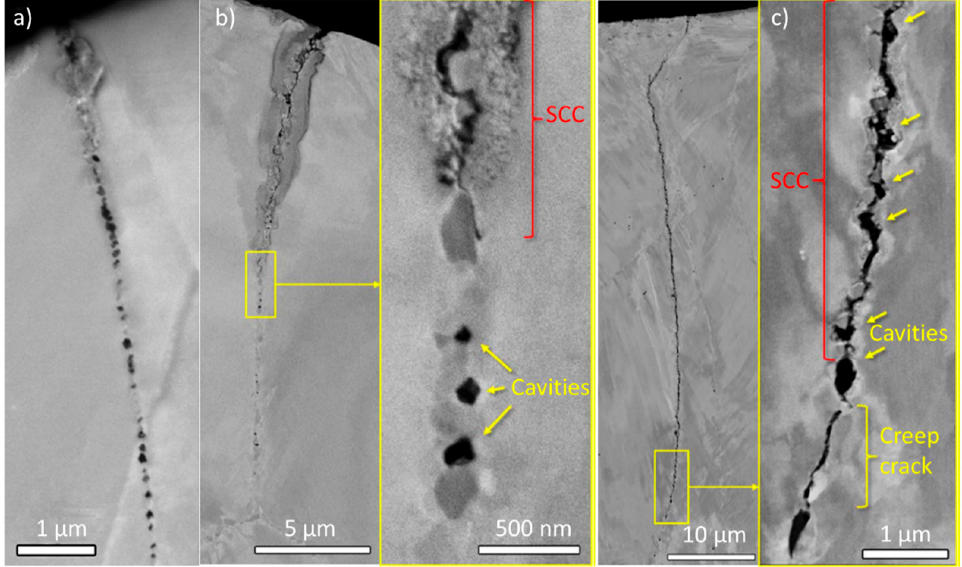
Figure 8. SEM-BSE images of cross-sections of EAC initiation in 21–31% CW Alloy 690, after testing conducted at 360 °C in simulated PWR primary water (600 ppm of B; 1 ppm of Li; 25 cc/kg dissolved H, i.e., in Ni/NiO transition conditions), showing the presence of GB cavities assisting the cracking. Three examples of the GB cavities are shown: ( a ) the first penetration at 5,352 h, ( b ) a shallow IG crack at 10,049 h, and ( c ) a mature crack at 11,709 h [61], reproduced from [63], with permission from Elsevier, 2020.